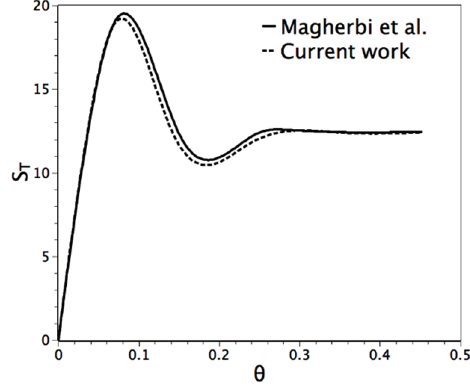
Figure 5. Total entropy production vs. dimensionless time θ ( 2 / t L = α ).